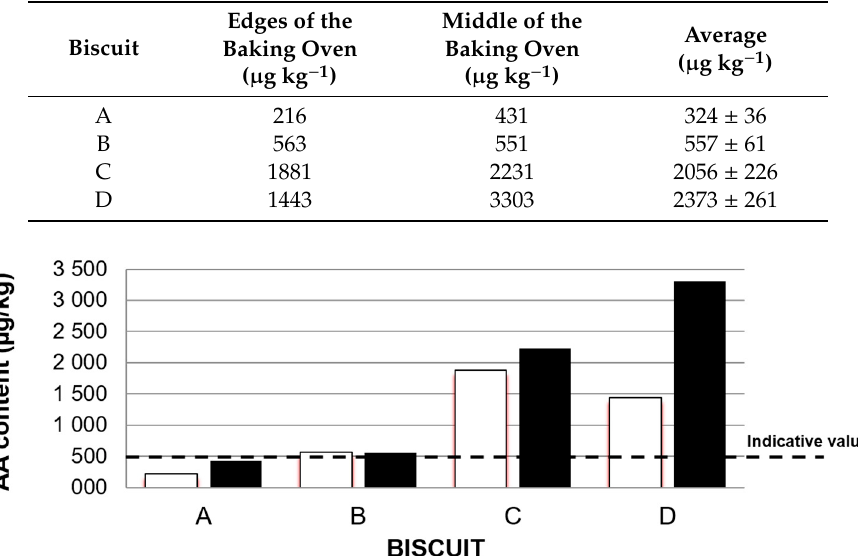
Table 2. Acrylamide content ( µ g kg − 1 ) in biscuits collected from di ff erent points of the baking oven. Edges of the Middle of the Biscuit Baking Oven ( µ g kg − 1 )